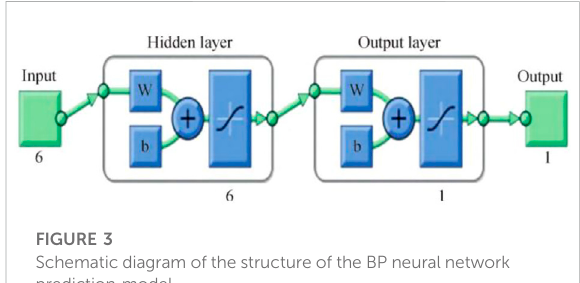
FIGURE 3 Schematic diagram of the structure of the BP neural network prediction model.